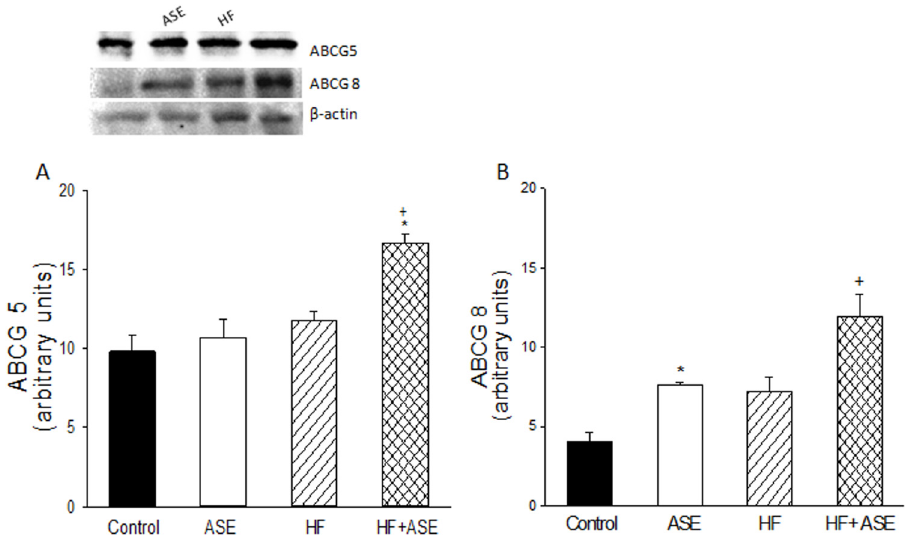
& Significantly different from the control group (p (cid:1) .05). * Significantly different from the control and ASE groups (p (cid:1) .05). + Significantly different from the corresponding HF group (p (cid:1) .05).